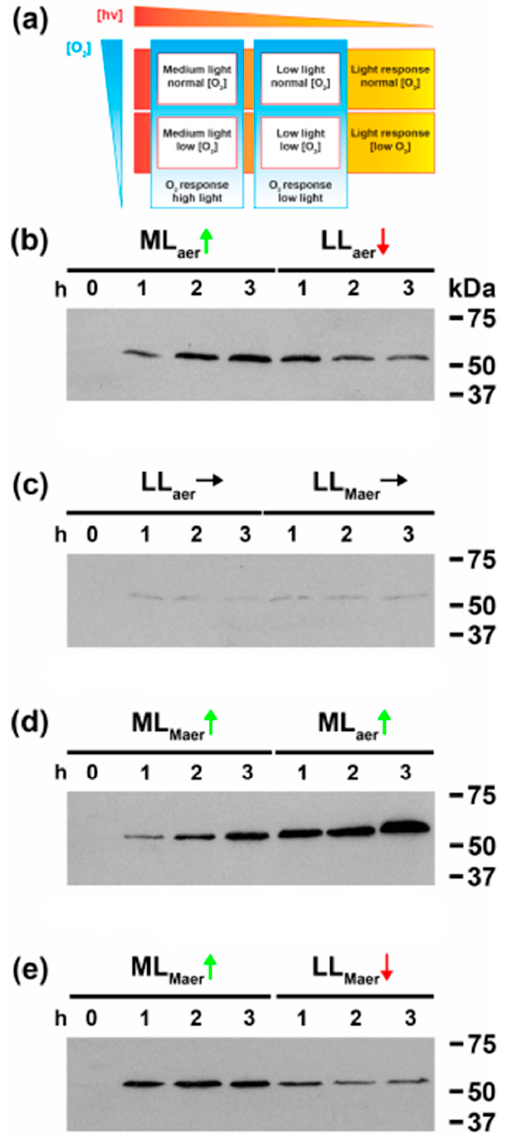
Figure 1. Combinatorial effects of varying oxygen availability and light quantity confirm redox regulation. CrhR accumulation was evaluated by Western blot analysis in wild type Synechocystis cells exposed to the indicated stresses. Cells were grown to mid-log phase at 30 ◦ C and subjected to: ML = Mid Light (150 µ mol m − 2 s − 1 ); LL = Low Light (36 µ mol m − 2 s − 1 ); AER = Aerobic conditions (bubbling with air); or MAER = Microaerobic conditions (bubbling with 95% N 2 + 5% CO 2 ). ( a ) Outline of interlinked experimental setup adapted from Barth et al. [12]. Experimental conditions are outlined in red. Response determined by transitioning between these conditions are displayed in red for light responses, and blue for O 2 response. ( b ) Light response with air levels of O 2 . Cells grown under LL AER conditions were sampled every hour after transfer to ML for 3 h and upon return to LL for 3 h. ( c ) Light response with low O 2 . Cells grown under LL AER conditions were sampled for 3 h before moving to MAER for 3 h. ( d ) O 2 response with ML. Cells grown under LL AER conditions were transferred to ML + MAER for 3 h before return to AER for 3 h. ( e ) O 2 response with LL. Cells grown under LL AER conditions were transferred to ML + MAER for 3 h before return to LL for 3 h. Soluble protein (20 µ g) was separated by SDS-PAGE and CrhR protein abundance determined by Western blotting using anti-CrhR antibody (1:5000) and ECL detection (26). While we have previously shown that crhR expression is regulated by a number of abiotic stresses through their common effect on the redox poise of the ETC [10,11],